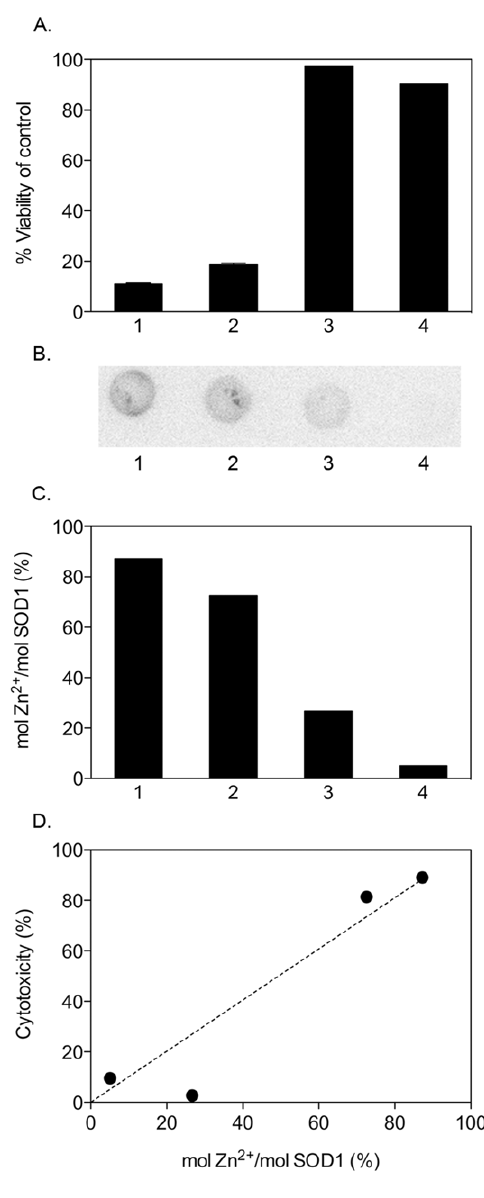
Figure 7. Intracellular Zn 2 + is transferred to cytotoxic apoSOD1 proteins. Monomeric apoSOD1 [C6/111A;F50E;G51E] ( 1 ) and the mutants [H46/48/120S] ( 2 ), [H71/80S;D83S] ( 3 ) and [H46/48/63/71/80/ 120S;D83S] ( 4 ) were added to a final concentration of 10 m M to SH-SY5Y cells loaded with radioactive 65 Zn. Samples of the culture media were collected, concentrated dry on a 10 K filter and exposed to a phospho- imaging screen. As reference for signal quantification, we used lysate of 65 Zn-loaded cells and a standard series of known 65 Zn concentrations. Cell viability was measured in a parallel experiment. ( A ) Monomeric apoSOD1 [C6/111A;F50E;G51E] and [H46/48/120S], which both show high Zn 2 + affinity, reduce cell viability to below 20%, whereas the low Zn 2 + affinity mutants [H71/80S;D83S] and [H46/48/63/71/80/120S;D83S] have no significant effect on cell viability. ( B ) Filter radioactivity showing transfer of 65 Zn to the different SOD1 variants in panel A. The signal intensity declines with decreasing Zn 2 + affinity of the apoSOD1 proteins concentrated on the filter. The high-density patterns in 1 and 2 result from manufactured depressions in thefilter surface. ( C ) Themolar ratio of Zn 2 + to SOD1 decreases with the Zn 2 + affinity of the protein. 100% is the ratio expected if all 65 Zn present in the cells (quantified to 1.9 fmol/ 100 000 cells) would transfer to the protein. ( D ) Plot of cytotoxic response (1-viability %) vs. molar ratio of Zn 2 + to SOD1.